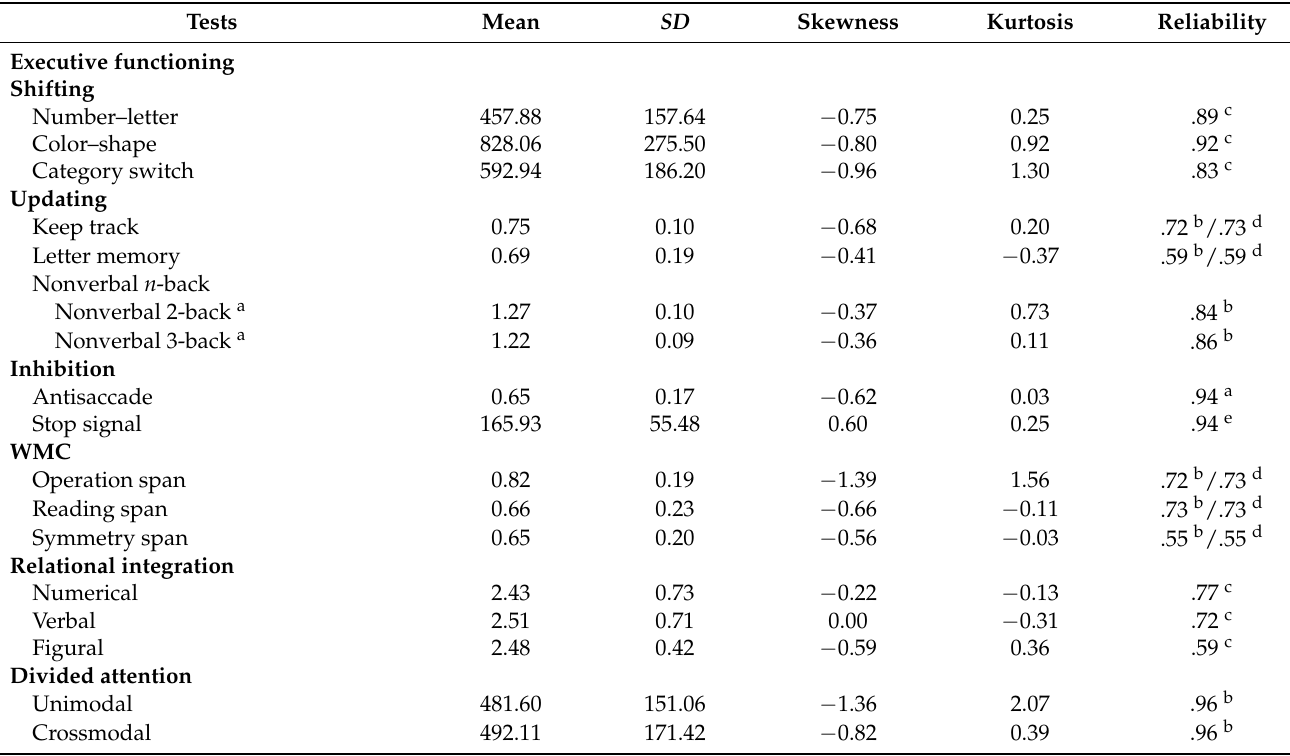
Table 2. Means, standard deviations (SD), and reliability estimates of the